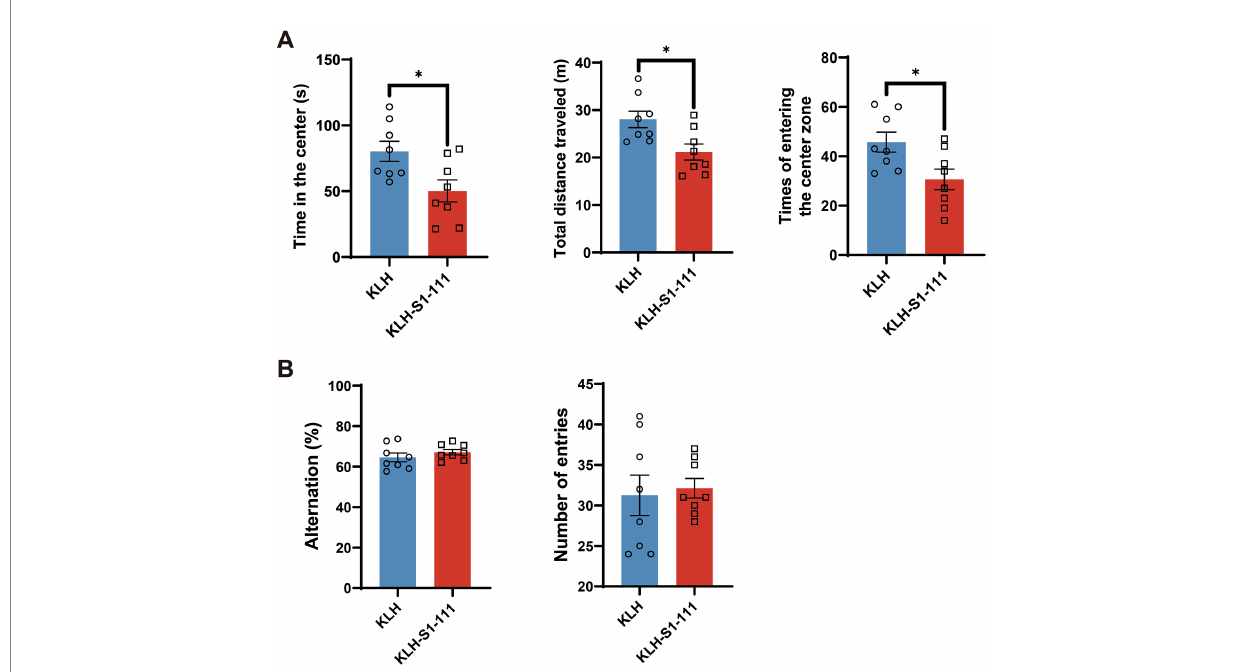
FIGURE 6 Behavioral effects of endogenous anti-KLH-S1-111 IgG antibodies in ApoE − / − mice. (A) Open field test (OFT). The time in the center ( p = 0.0185), total distance travelled ( p = 0.0131) and number of times entering the center zone ( p = 0.0207) were significantly decreased in the K-S group, unpaired Student’s t test. (B) Y maze test. The histogram shows no significant differences in the alternation rate or number of entries between the two immunized groups. (A,B) . N = 8/group, data are shown as the mean ±